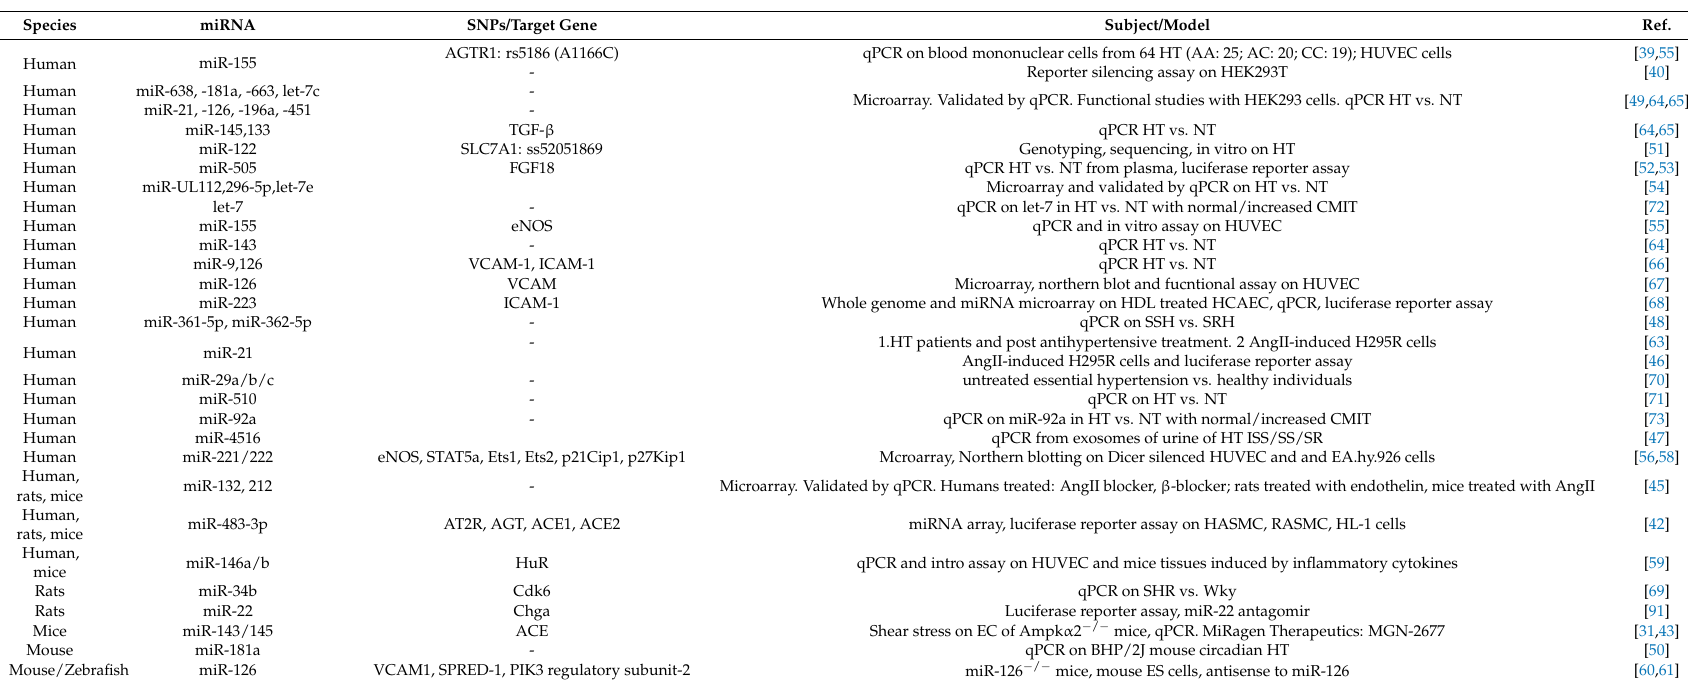
Table 3. miRNAs associated with hypertension based on